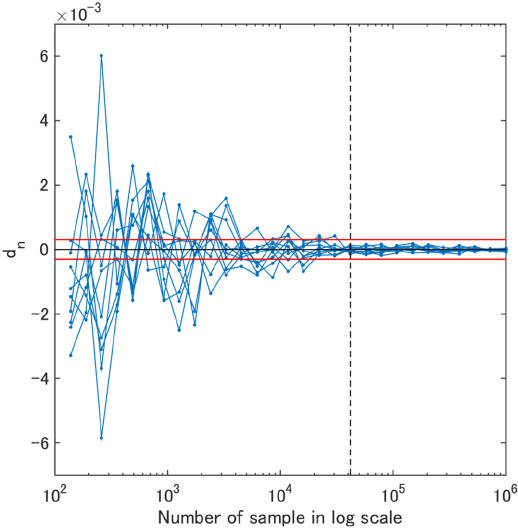
Figure 1. Variability in rate of change in the mean absolute difference (MAD) between MODIS-compatible EVI and MODIS EVI ( d n ) as a function of the number of sample data. A vertical dashed line corresponds to the number of sample 41,754.